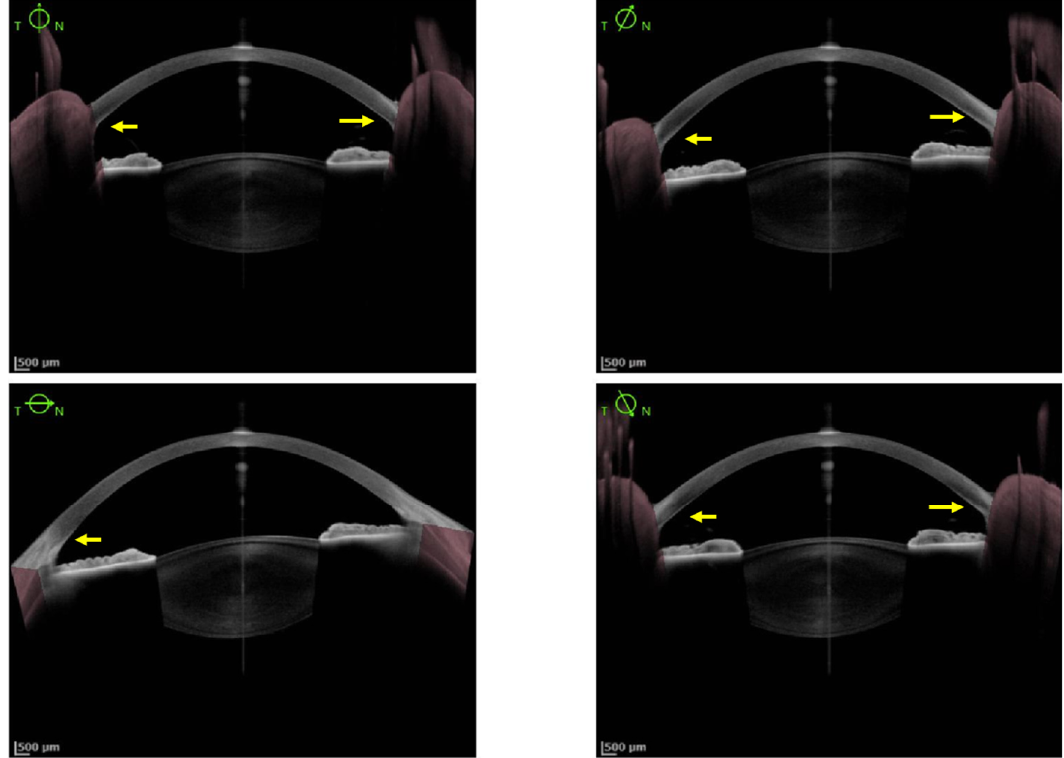
Figure 3. High-resolution Swept Source technology (Anterion ® , Heidelberg Engineering, Heidelberg, Germany) provides images of very high quality allowing the detection of a faint Kayser–Fleischer ring (KFR) hardly visible on slit-lamp examination (yellow arrow).